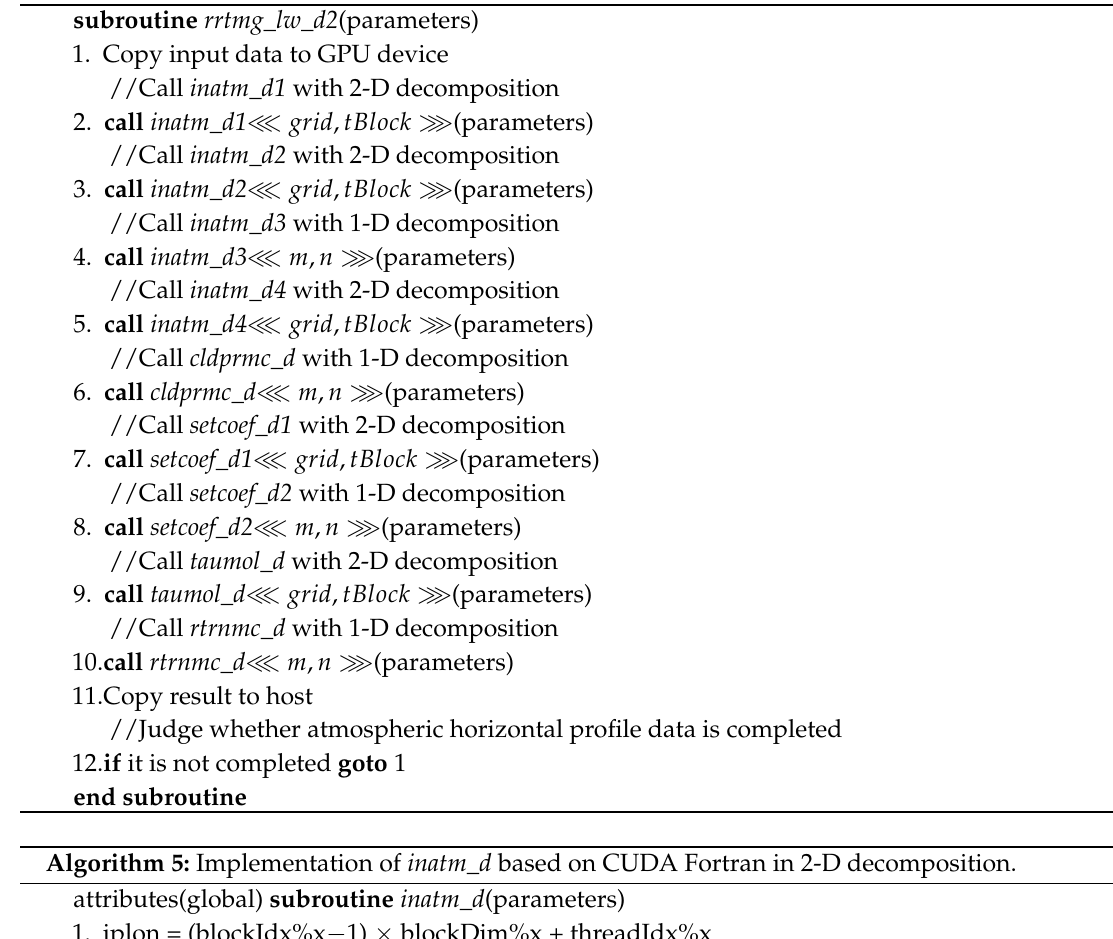
Algorithm 4: CUDA-based acceleration algorithm of RRTMG_LW with 2-D domain decomposition and the implementation of 2-D G-RRTMG_LW.